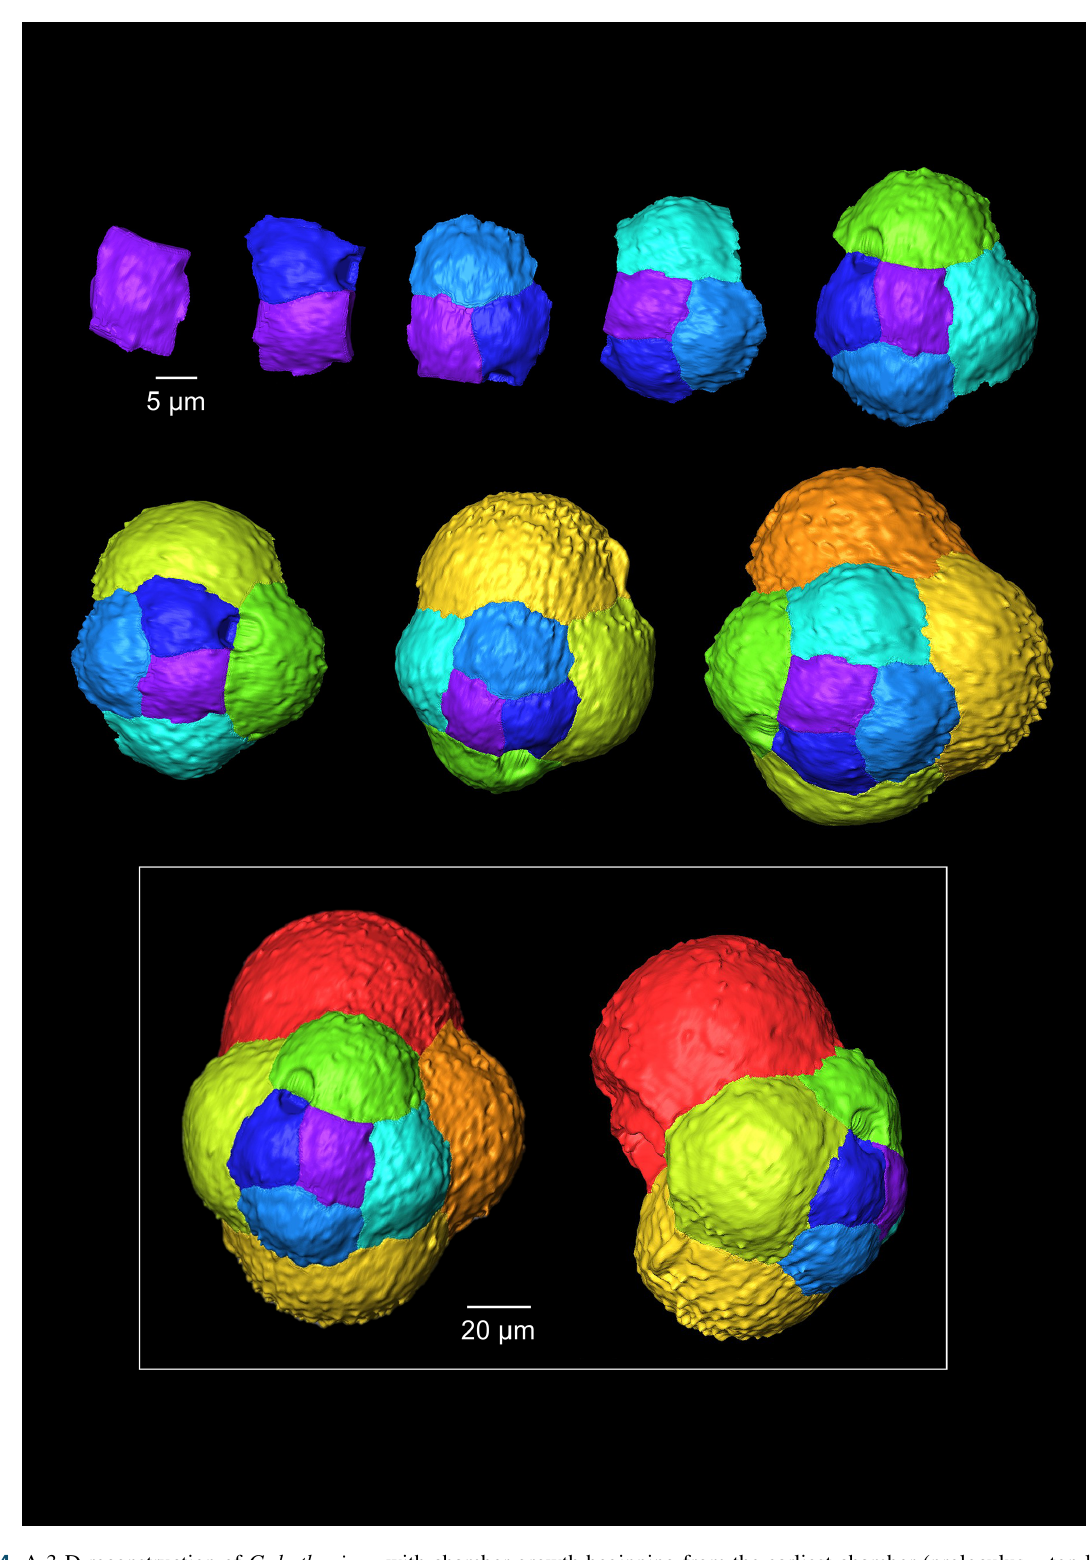
Figure 4. A 3-D reconstruction of G. bathoniana with chamber growth beginning from the earliest chamber (proloculus – top left) to the terminal chamber (in the white box). The terminal chamber is presented in spiral and side view, and it is manipulated so that the most recent chamber is at the top. Preservation challenges meant that the earliest chambers were difficult to